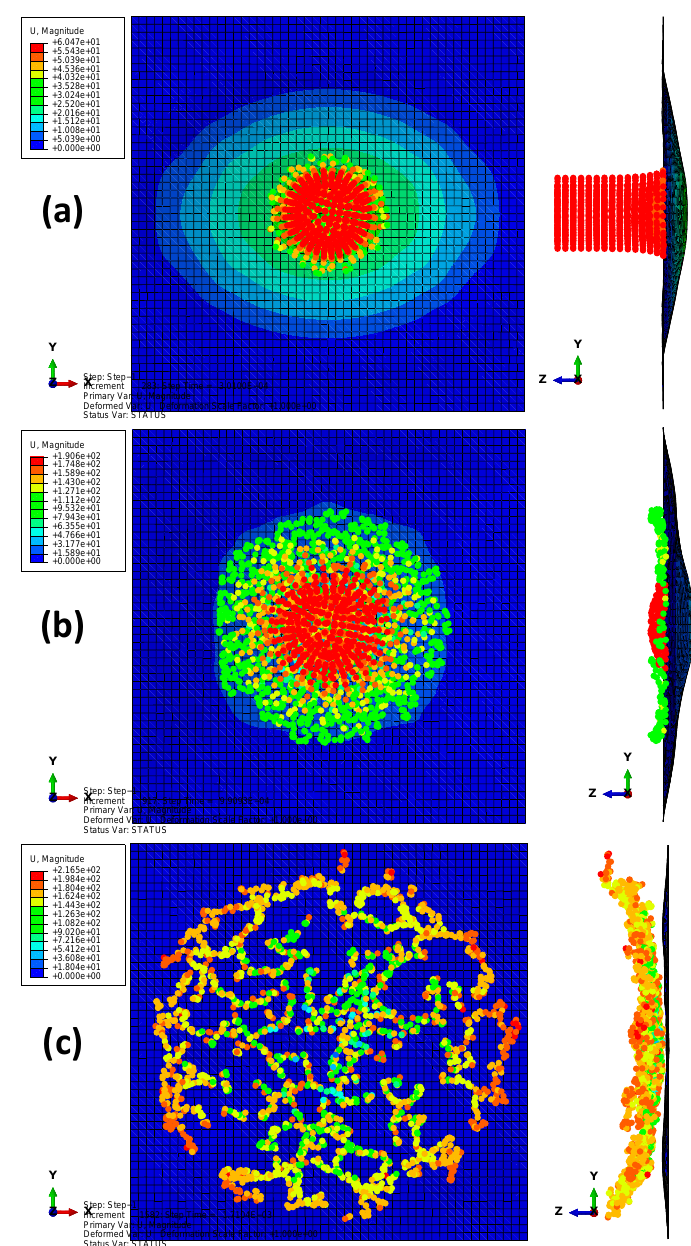
Figure 4. Projectile deformation series in the model of laminate with material 3: ( a ) 0.3 ms; ( b ) 1.0 ms; ( c ) 1.7 ms.